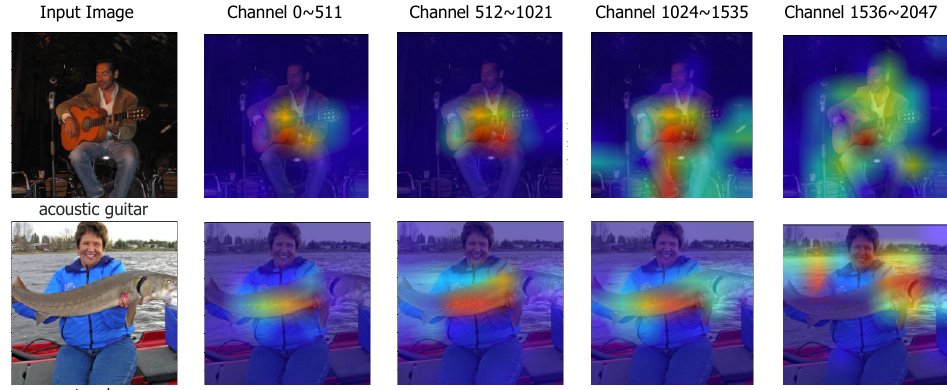
Figure 2. Grad-CAM visualization of channels with respect to